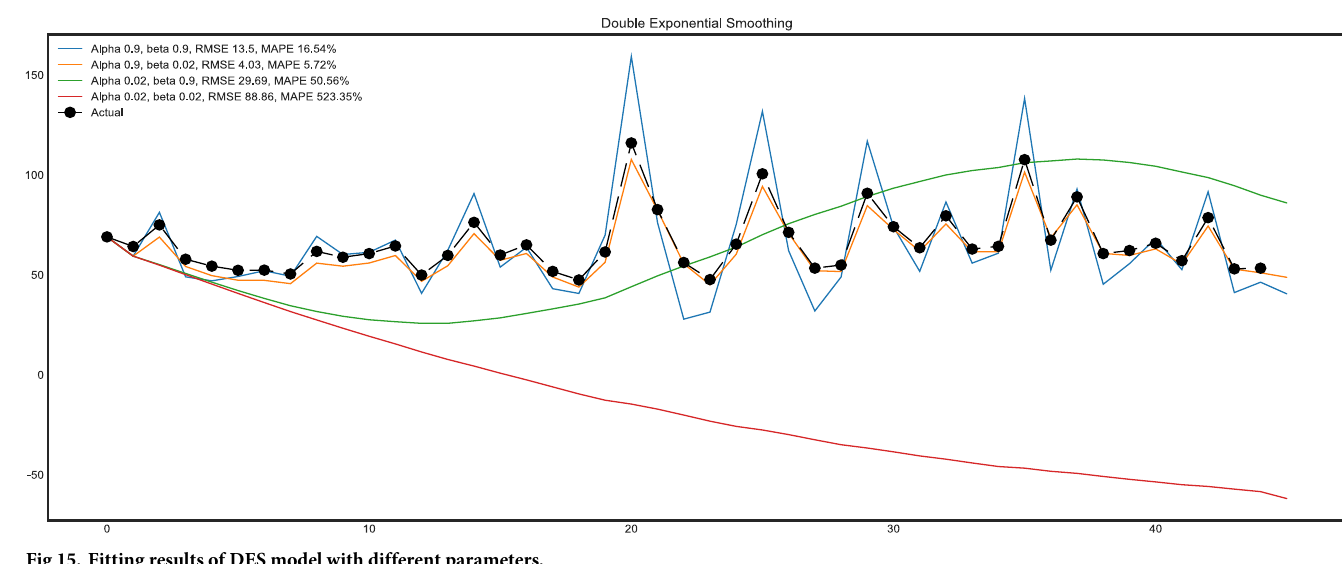
Fig 15. Fitting results of DES model with different parameters.